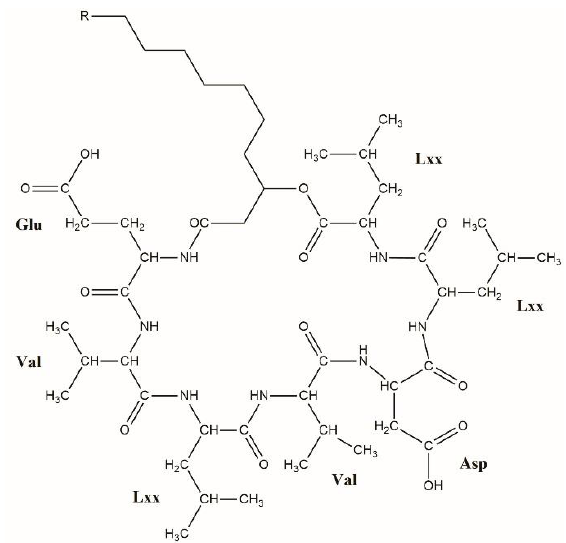
Figure 1. The structure of the surfactin variant [Val2] described by Bóka et al. [6]. R = C 3 H 7 –C 5 H 11 . Table 1. Natural surfactin peptide sequence variants including the recently found isoforms containing AME in the fifth position.